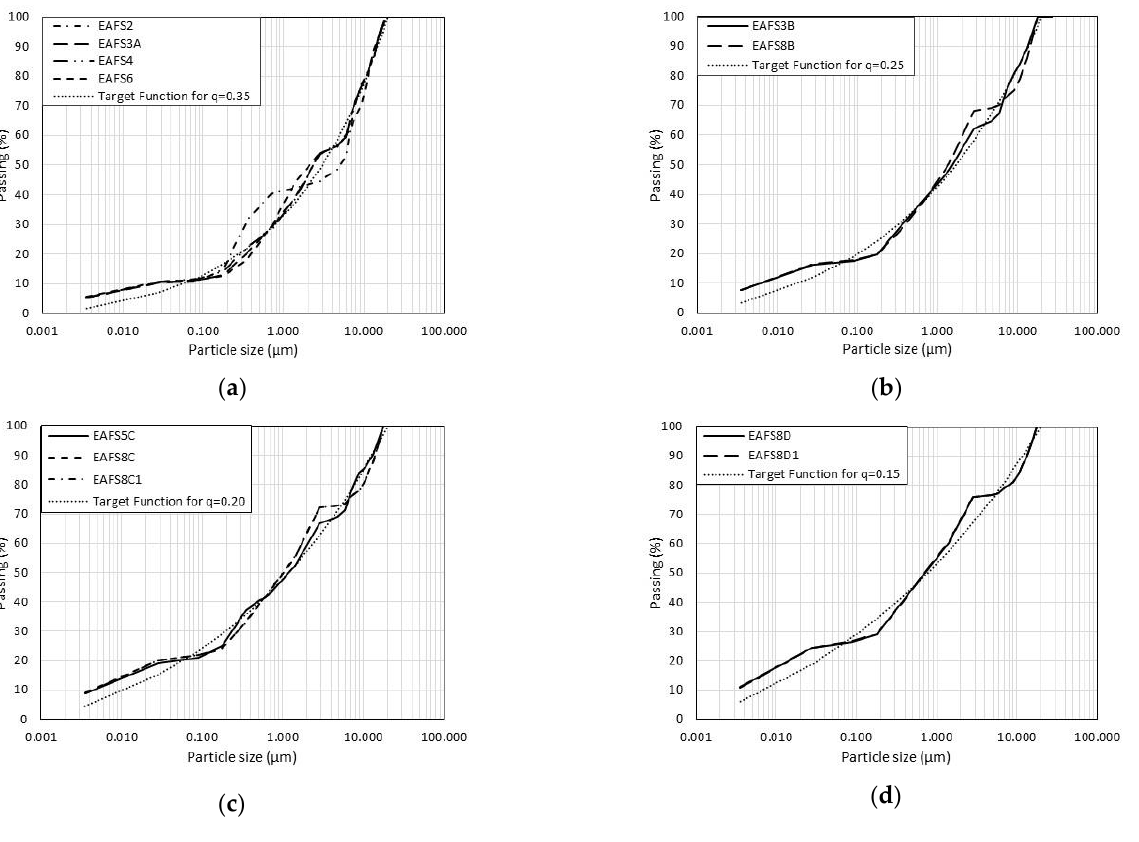
Figure 3. Particle size distribution of the target and resulting grading curves of the EAFS mixtures: ( a ) for q = 0.35; ( b ) For q = 0.25; ( c ) for q = 0.20; ( d ) for q =